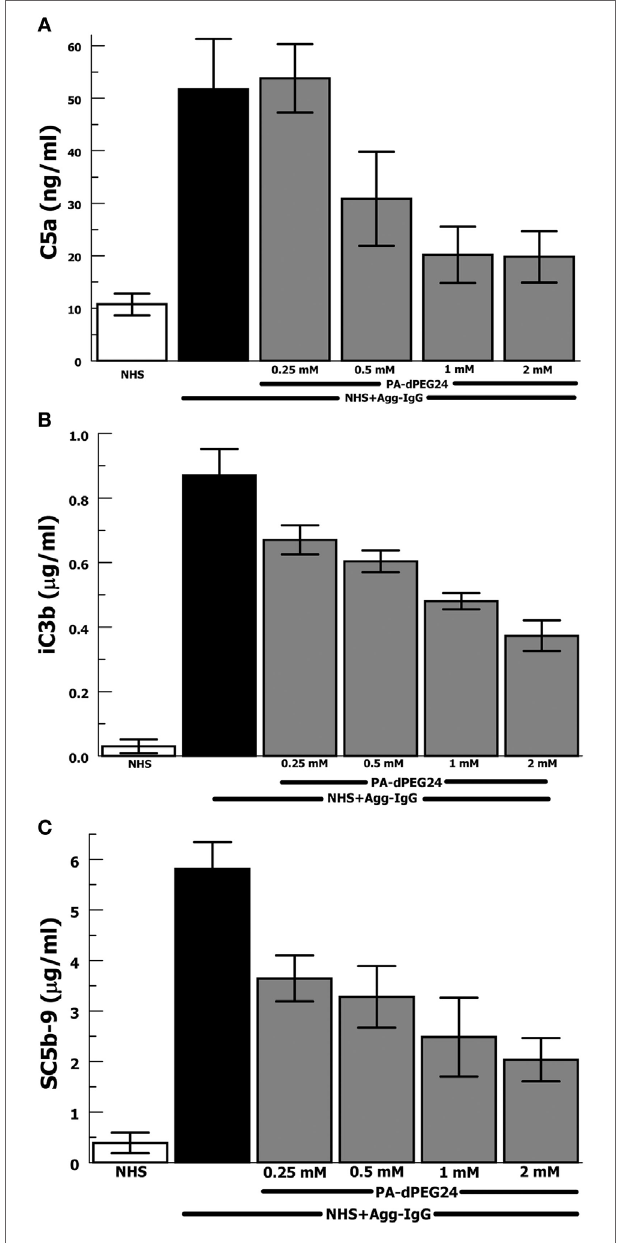
FigUre 2 | PA-dPEG24 inhibition of ovalbumin–antiovalbumin immune complex-initated complement activation assayed by complement effectors. (a) PA-dPEG24 inhibition of C5a generation in normal human sera (NHS) stimulated with ovalbumin–antiovalbumin immune complexes (IC). Data are means of ( n = 4) independent experiments ± SEM. (B) PA-dPEG24 inhibition of iC3b generation in NHS stimulated with ovalbumin–antiovalbumin IC. Data are means of ( n = 4) independent experiments ± SEM. (c) PA-dPEG24 inhibition of SC5b-9 generation in NHS stimulated with ovalbumin– antiovalbumin IC. At 2 mM PA-dPEG24 the measured SC5b-9 was at the lower limit of detection. Data are means of ( n = 3) independent experiments ± SEM.